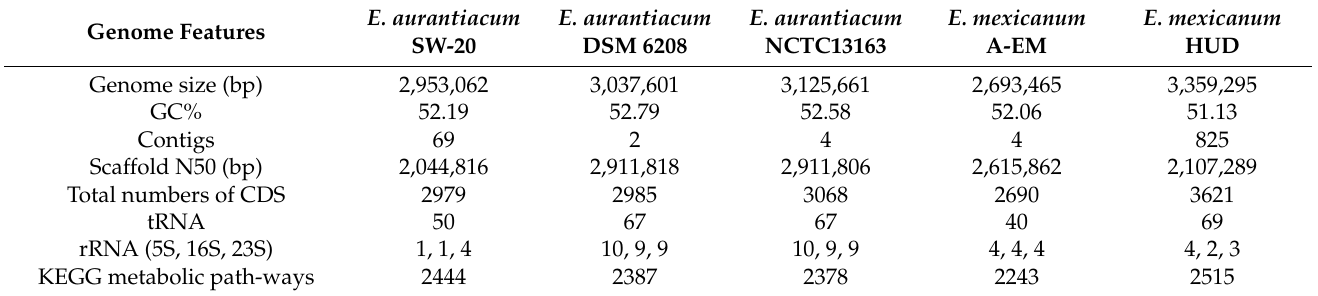
Table 1. Genome features of E. aurantiacum SW-20, E. aurantiacum DSM 6208, E.